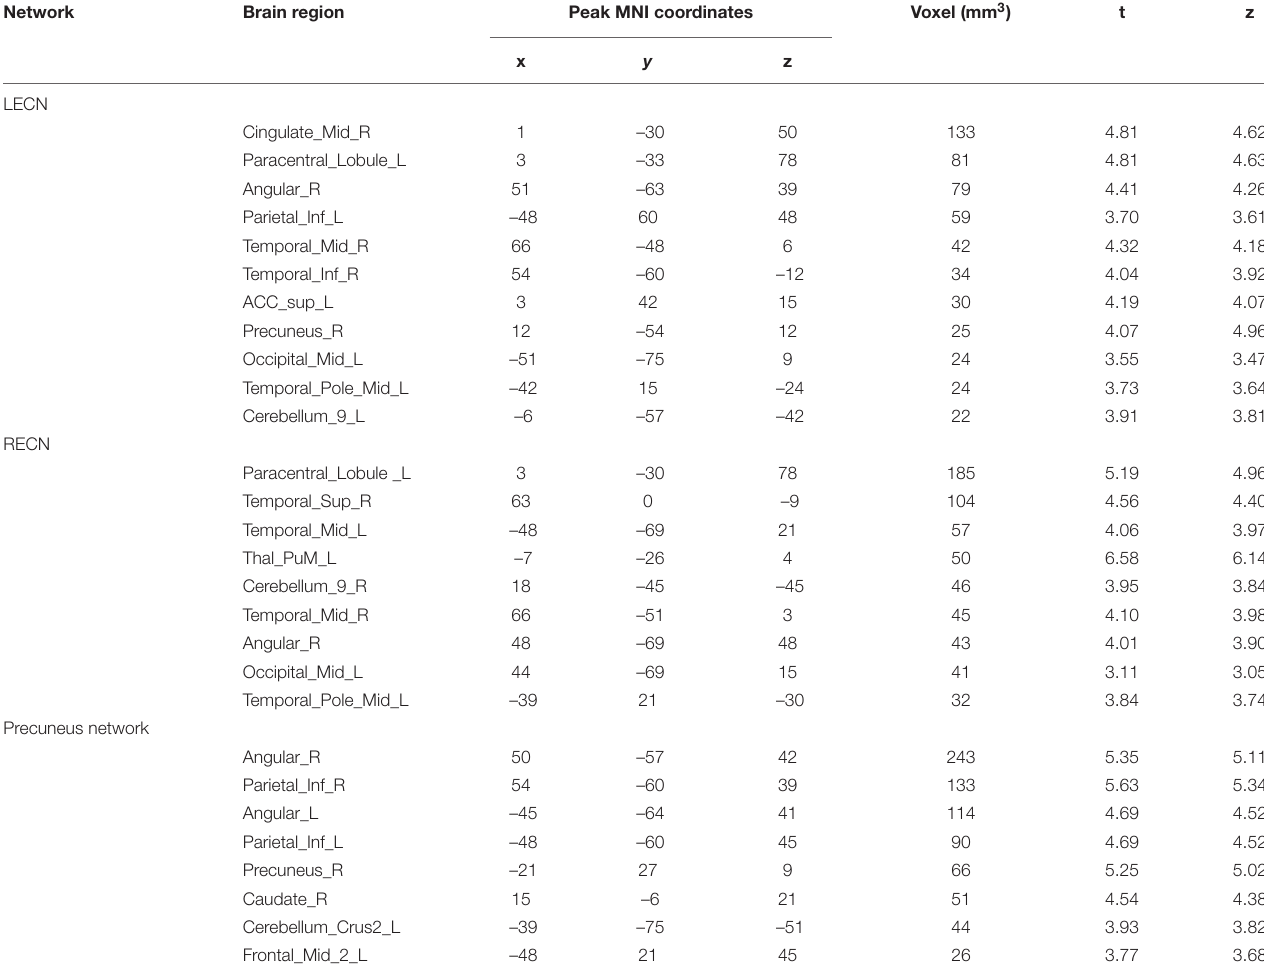
TABLE 3 | Abnormal external network connectivity in patients with type 2 diabetes mellitus compared to normal controls. Network Brain region Peak MNI